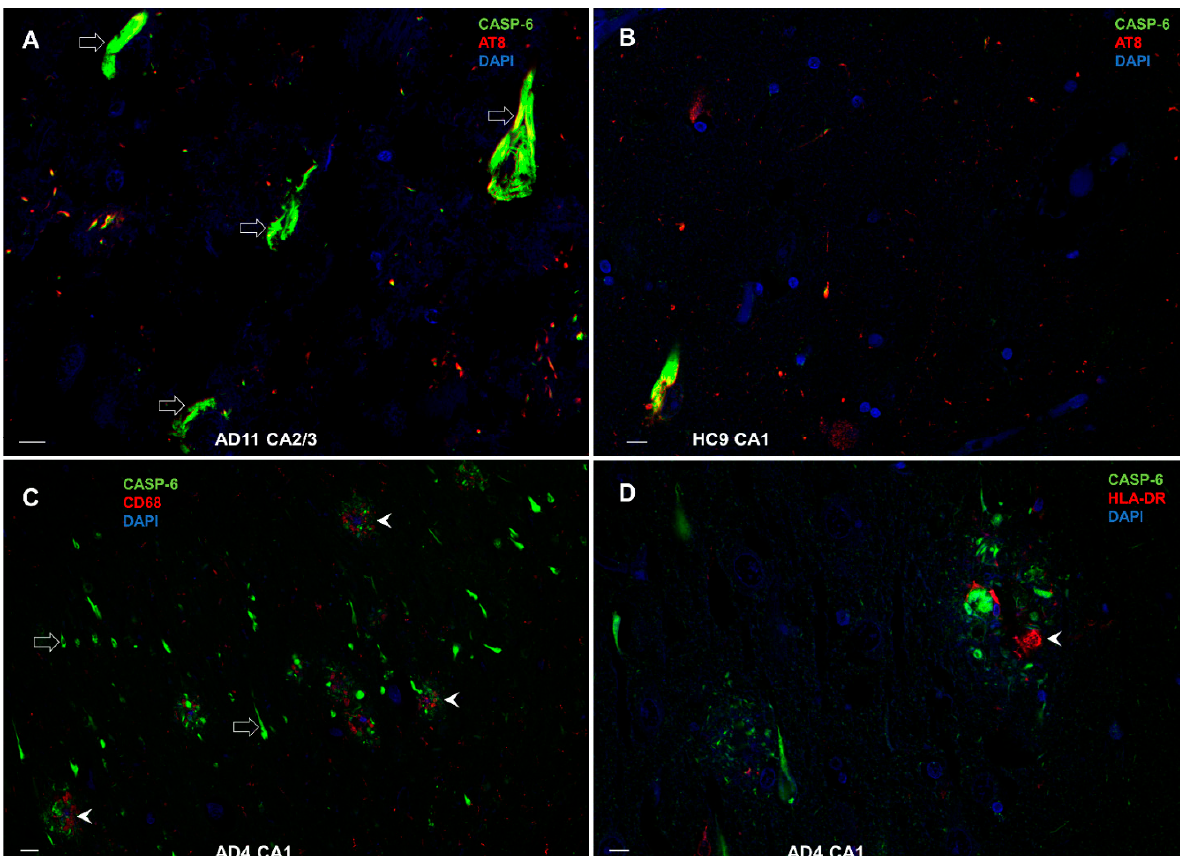
Figure 13. Colocalization of CASP-6 with phosphorylated tau (AT8), CD68, and HLA-DR. ( A ) CASP-6 and phosphorylated tau (AT8) in NFTs (empty arrows) in AD. ( B ) Colocalization is rare in HC, where NFTs are few. ( C ) CASP-6 and CD68 near amyloid/neuritic plaques in AD hippocampus (arrowheads). ( D ) The distribution and colocalization of CASP-6 and HLA-DR in AD are also prevalent in amyloid/neuritic plaques (arrowhead). Scale bars in A, B, and D = 10 μ m, in C = 50 μ m.